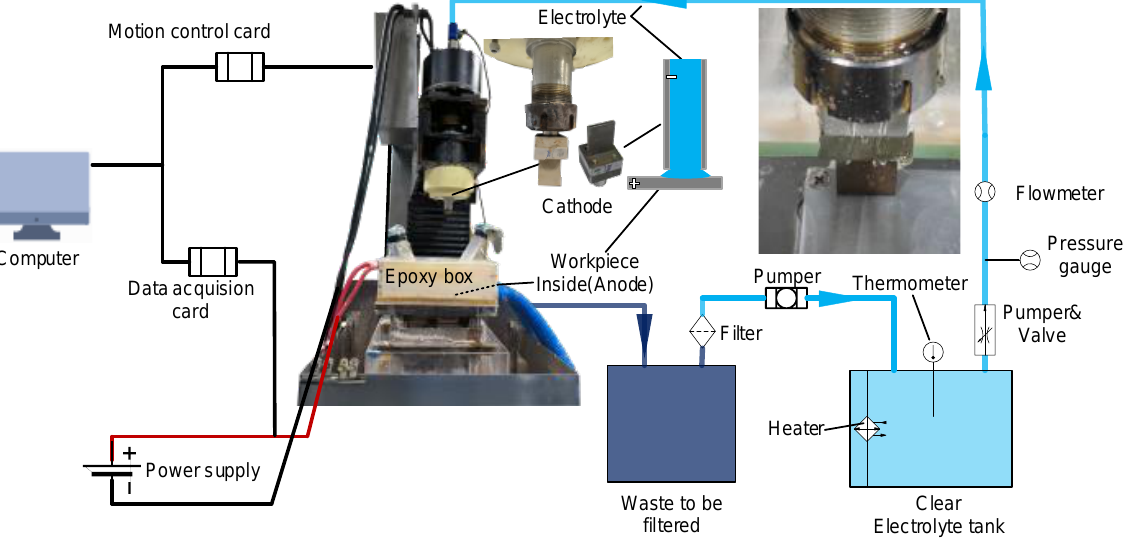
Figure 2. ECM system. The light blue line is the clear liquid transportation pipeline, and the dark blue line is the transportation pipeline of turbid liquid, which will be filtered after processing. Processing stage photo (Unpowered) is displayed in the upper right corner of the full image. The electrolyte flows from top to bottom inside the machine tool along the hollow electro-spindle, sprays from the opening of the tool cathode, and flows into the waste liquid tank from the blue pipe at the bottom right of the ECM machine. Table 4. Parameters of the single-groove milling